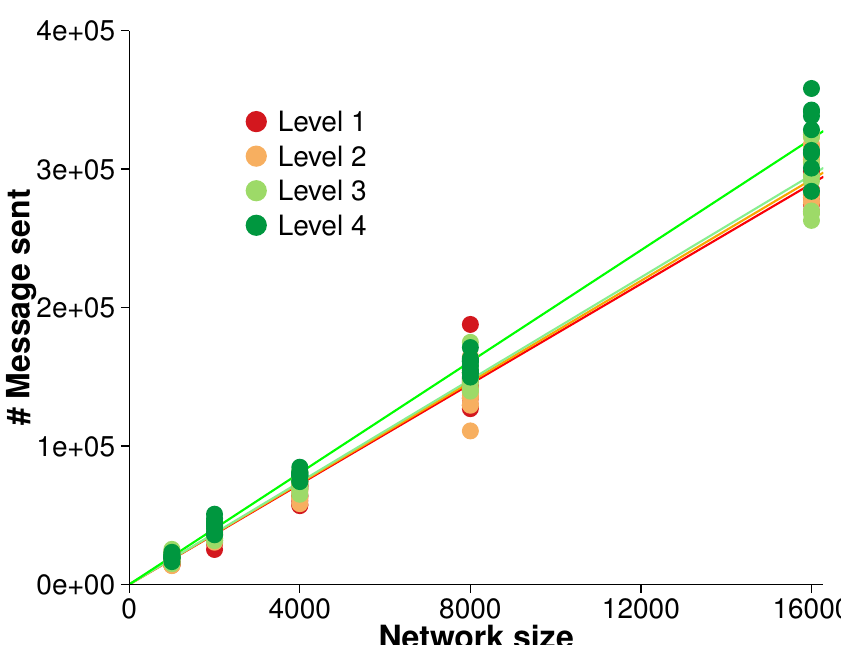
Figure 6. Overall scalability for monitoring events (averaged over 10 randomized networks and 10 consecutive time steps in each evolution).